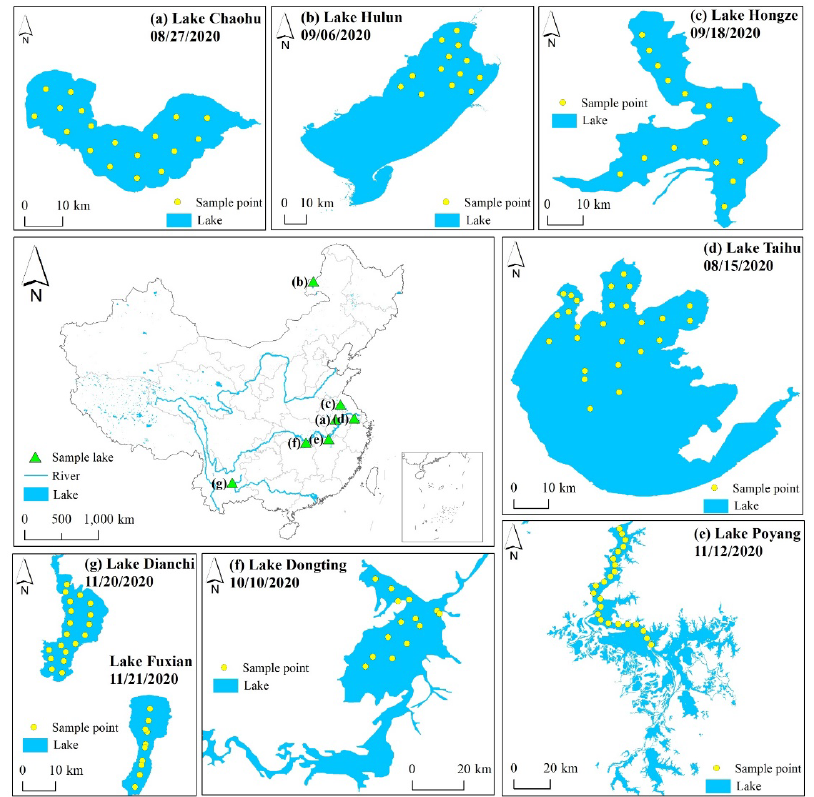
Figure 3. Location and date of in situ data in eight lakes, comprising Yangtze River-linked lakes (Lake Poyang, Dongting, and Hongze) and Yangtze River-nonlinked lakes (Lake Taihu and Chaohu) in Yangtze Plain and the Huaihe River Basin, Lake Hulun in Inner Mongolia, and Lake Dianchi and Fuxian in the Yunnan–Guizhou Plateau.